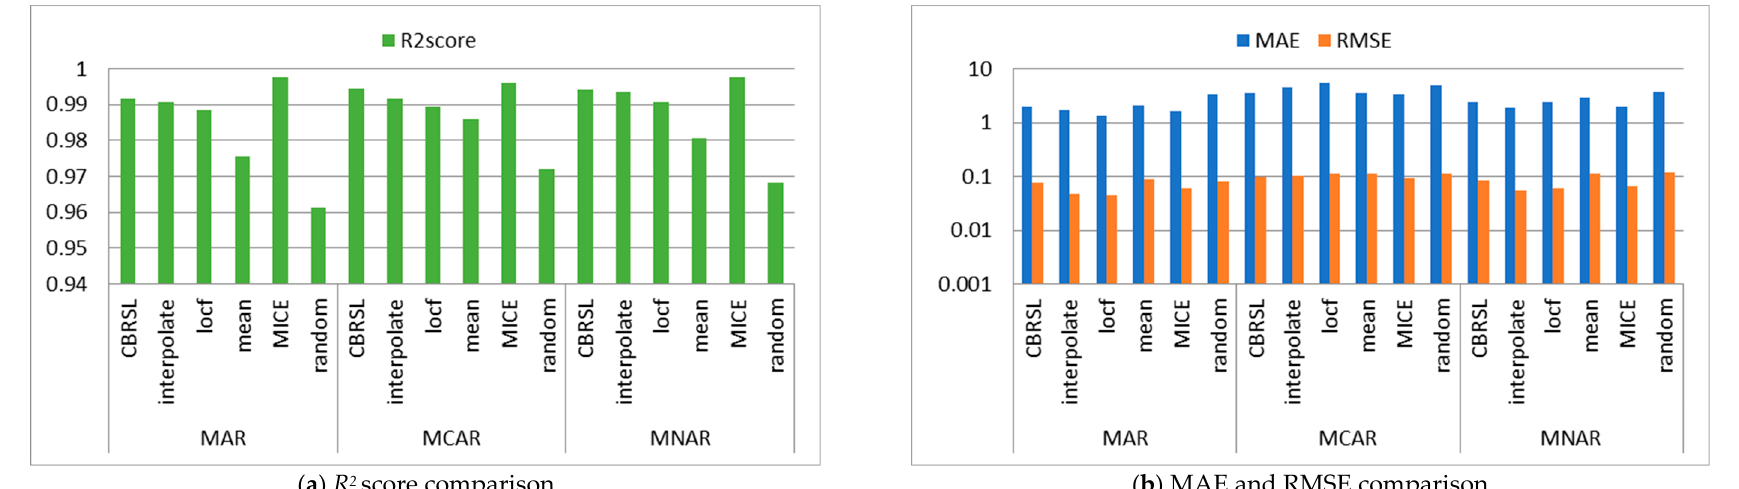
Figure 2. Comparison between the proposed algorithm, interpolate, locf, mean, MICE and random methods (Parkinson’s Dataset).